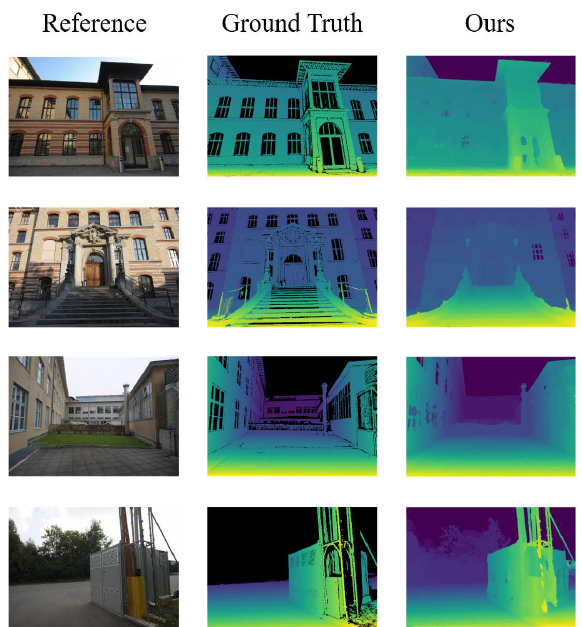
Figure 1. Illustration of high-quality disparity